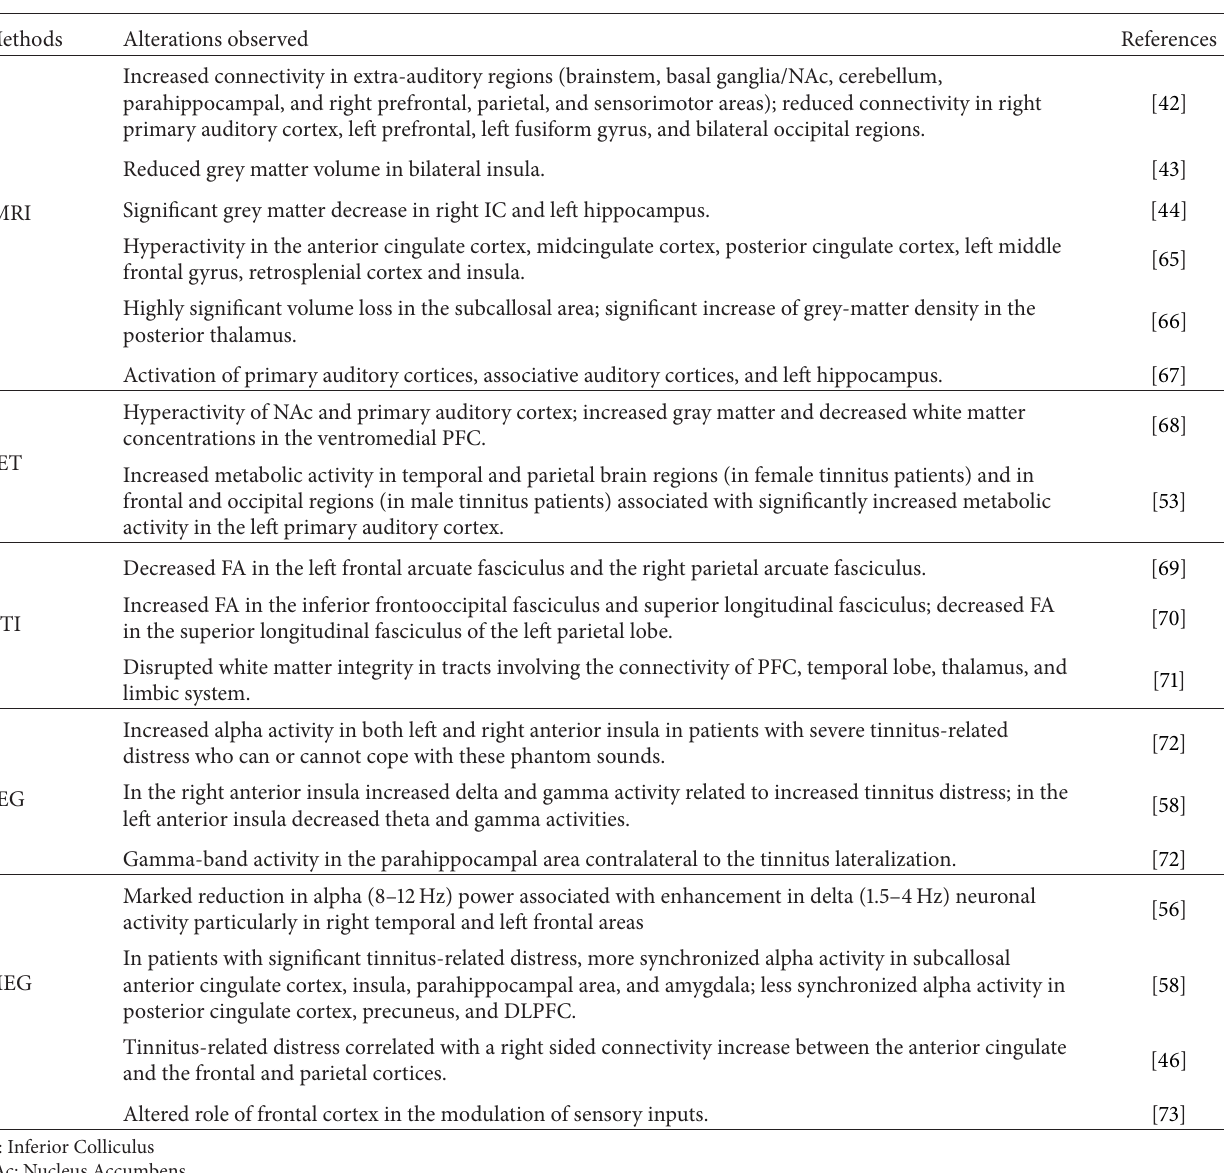
Table 3: Tinnitus-related alterations “beyond” auditory